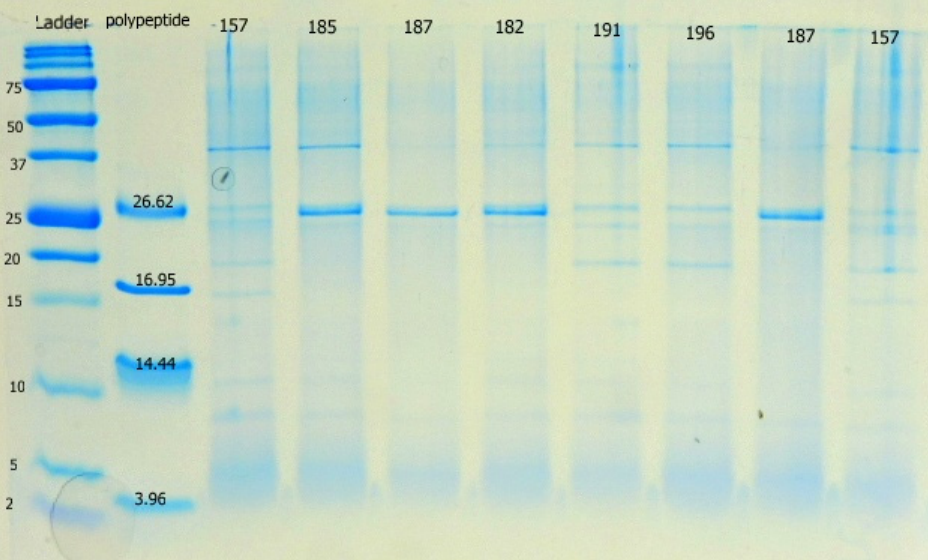
Figure 1. The proteomic profile of extracellular products of L. plantarum strains isolated from silages on 15% Tricine-SDS-PAGE gel. Chitinase bands in the 20 kDa range are visible in samples 191 and 196. Sample 157 is not included in this study. Precision Plus Protein TM Dual Xtra Standards was used as the peptide standard. Polypeptide Molecular Weight Standards TM represents insulin b chain (3.96 kDa), α -lactalbumin (14.437 kDa), myoglobin (16.95 kDa) and triosephosphate isomerase (26.62 kDa).